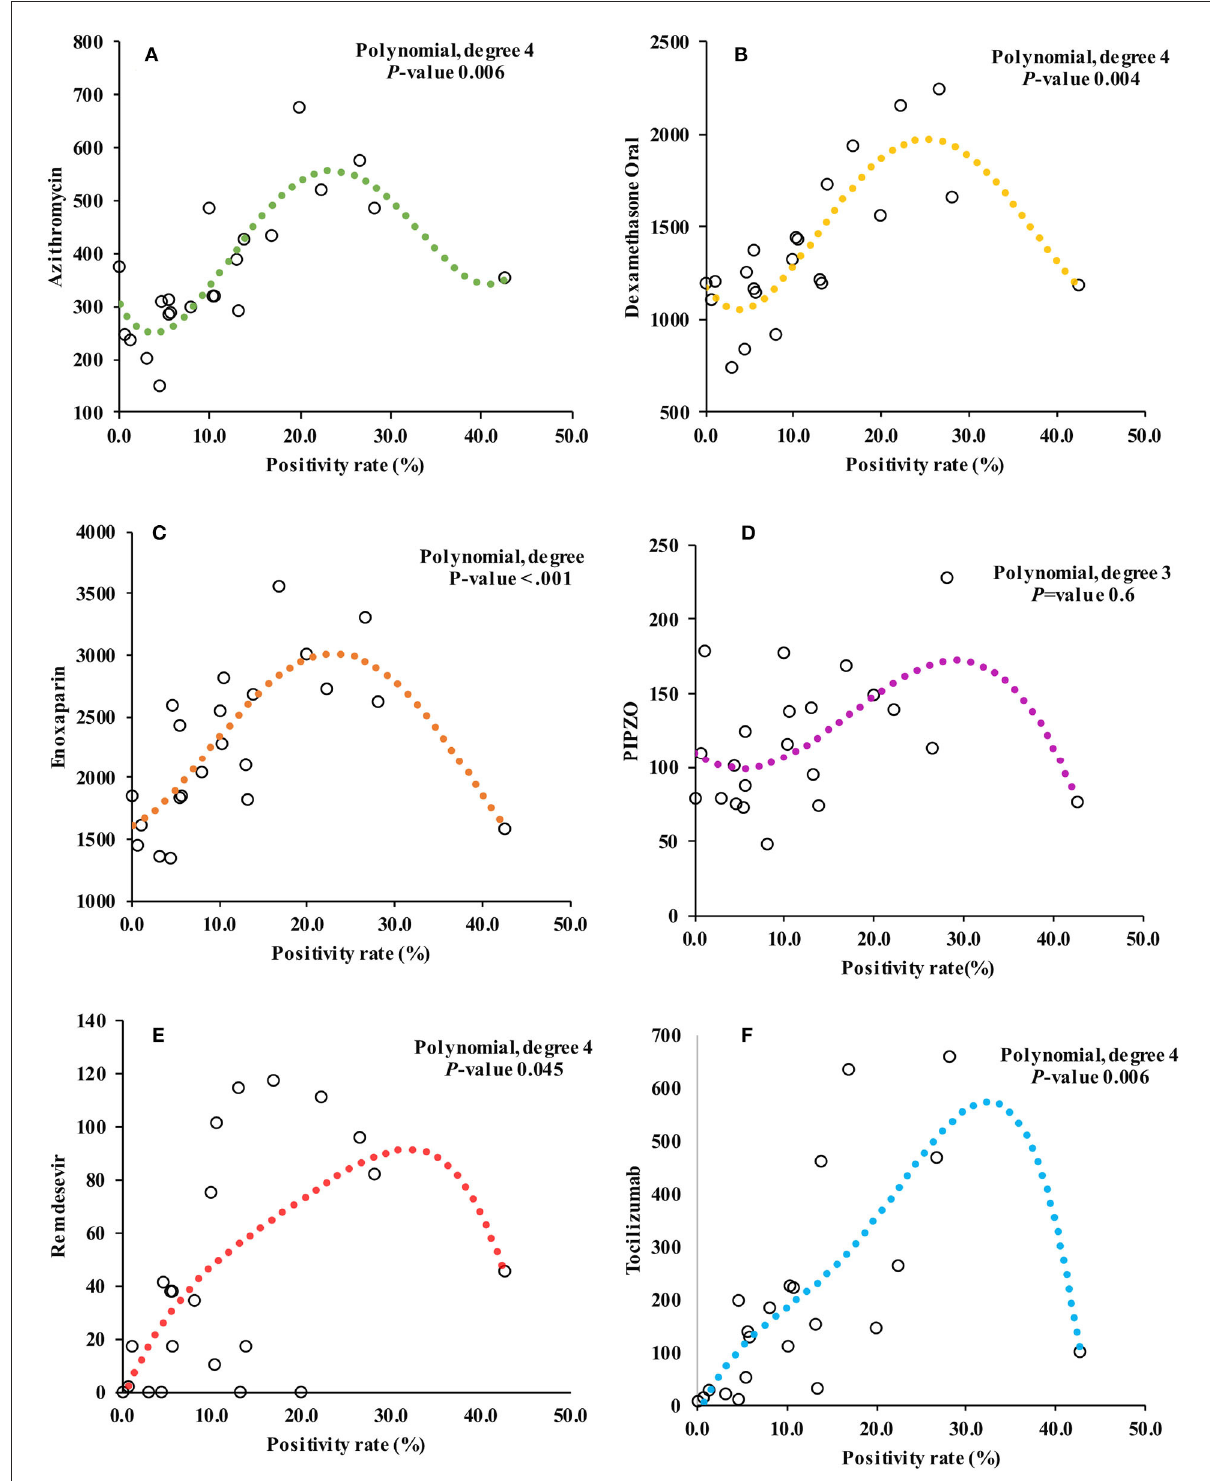
FIGURE3 Figure showing the relationship between positivity rate and monthly prescription drug utilization. (A–F) represent the models for azithromycin, oral dexamethasone, enoxaparin, piperacillin/tazobactam (PIPZO), remdesivir, and tocilizumab, respectively. The models are non-linear, and polynomial regression best fitted a quadratic model with the exception of PIPZO, (D) which best fitted a cubic model. The P -values for each model shown are the outcome of partial F-test to determine whether there was a statistically significant difference from the linear model. The model for PIPZO was not significant. Not shown, are models for fentanyl (quadratic model, p -value 0.03) and intravenous dexamethasone (cubic model, p -value